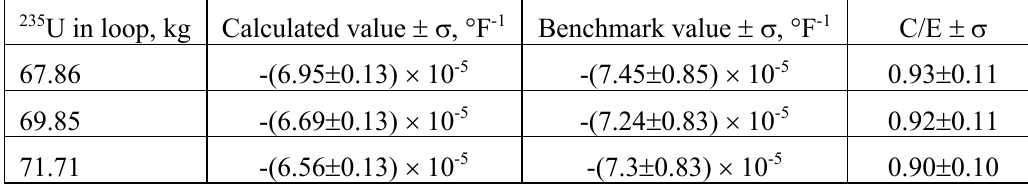
Table IV. Isothermal temperature